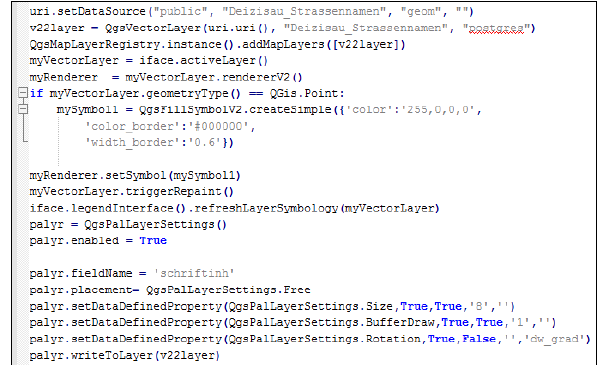
Figure 4: Python code for labelling street names